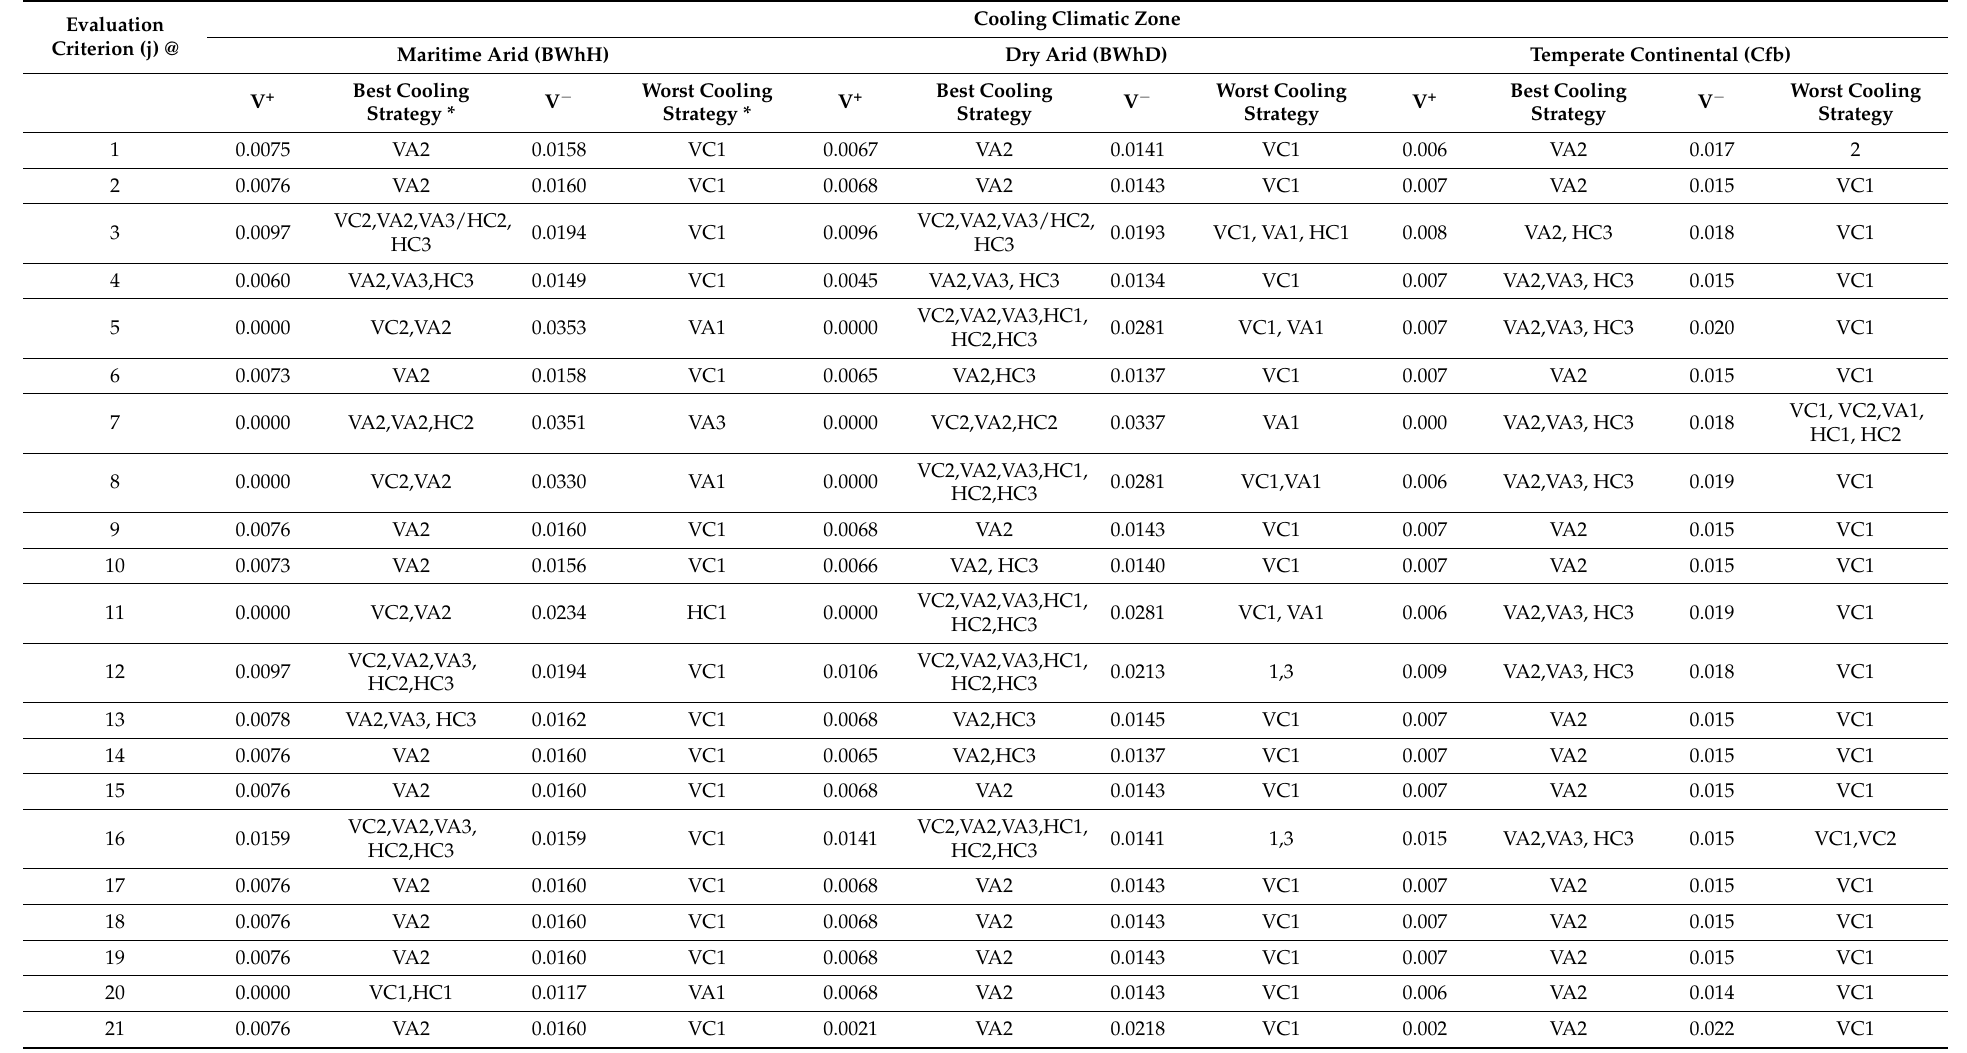
Table 14. Best V + and worst V − solution for each criterion for climatic zones using corresponding E j entropy weight